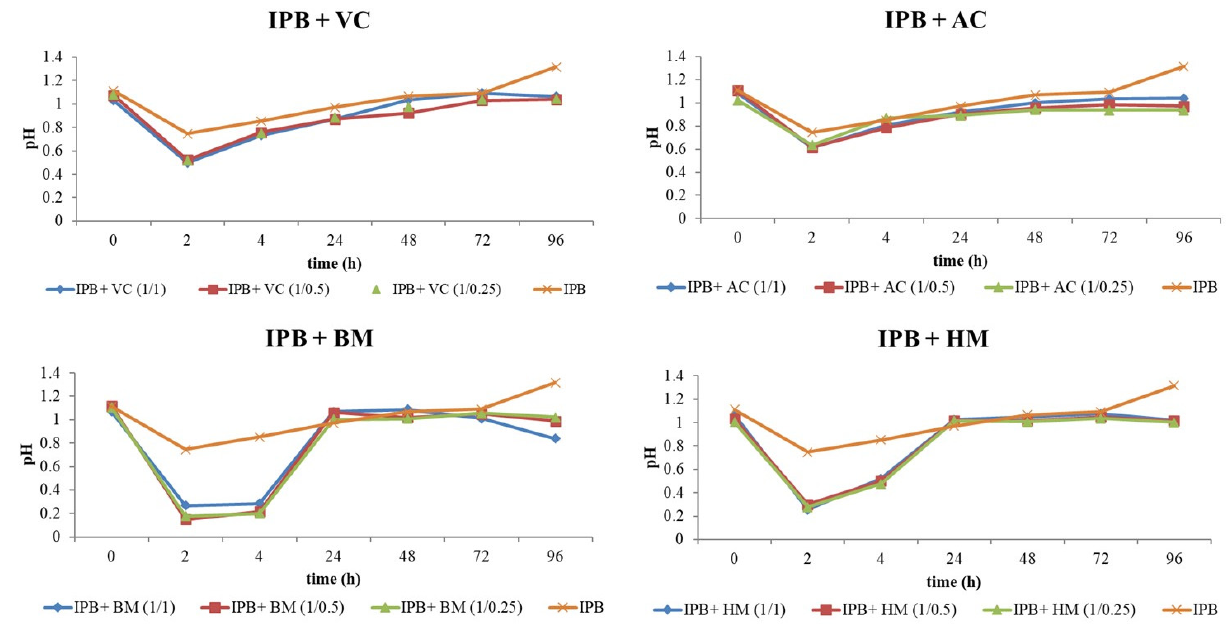
Figure 5. Evolution of pH at different reaction times (h).